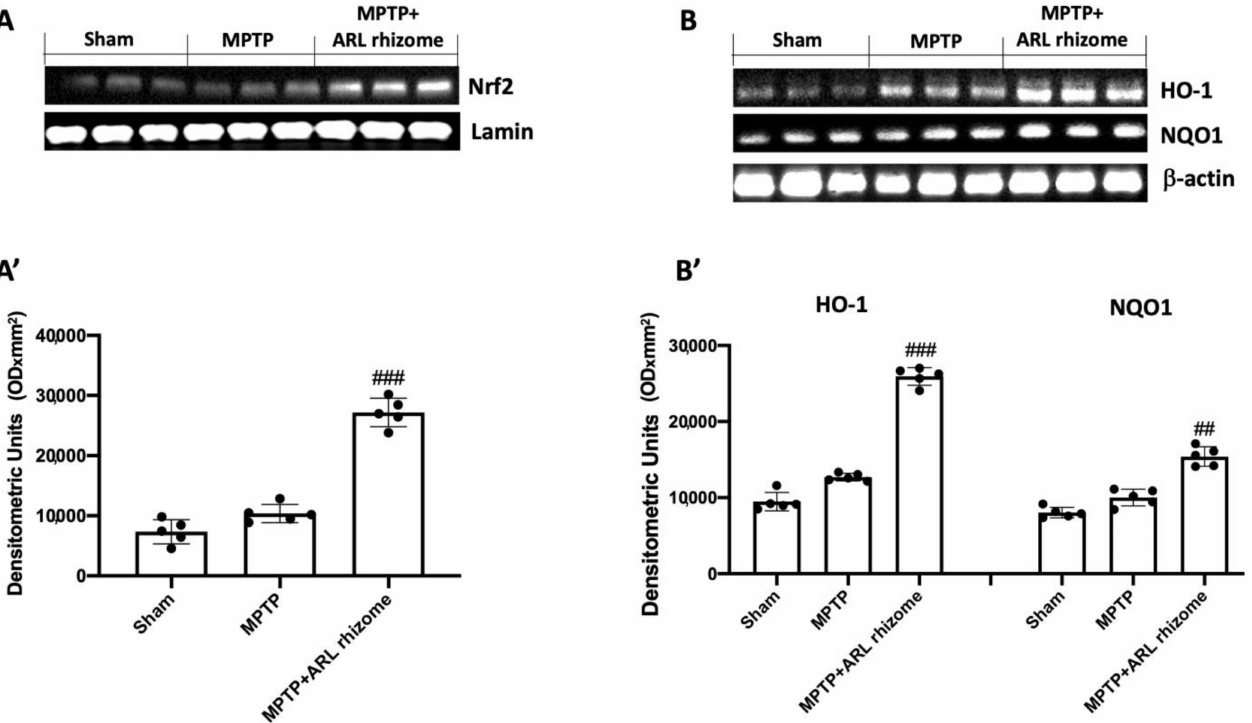
Figure 1. The impact of ARL rhizome on Nrf2/HO-1/NQO1 pathway expression after MPTP- injection. Representative Western blots were carried out for nuclear Nrf2 ( A , A’ ), cytoplasmic HO-1, and NQO1 ( B , B’ ) expression. A demonstrative blot of lysates (five animals/group) is given, along with a densitometric analysis for all animals ( A’ , B’ ). Values = means ± SD of five animals in each group. ## p < 0.01 vs. MPTP; ### p < 0.001 vs.